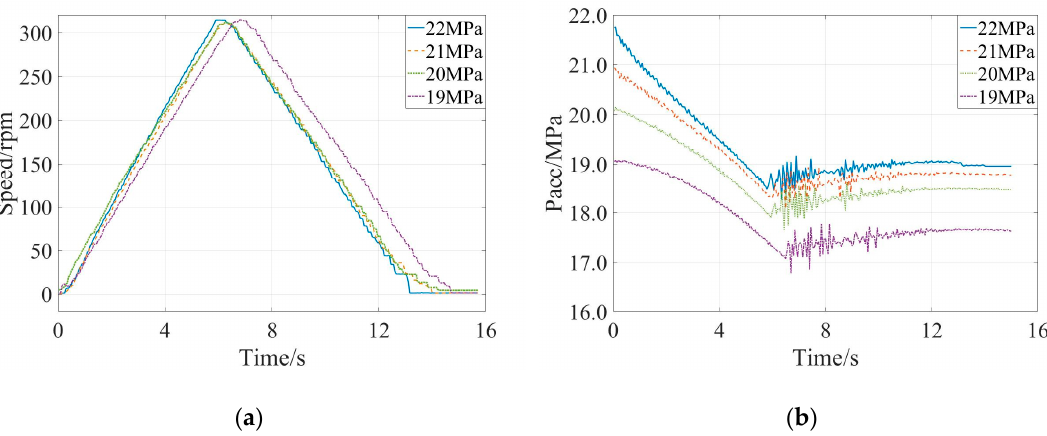
Table 6. The experimental results in the operating mode with different braking intensity.